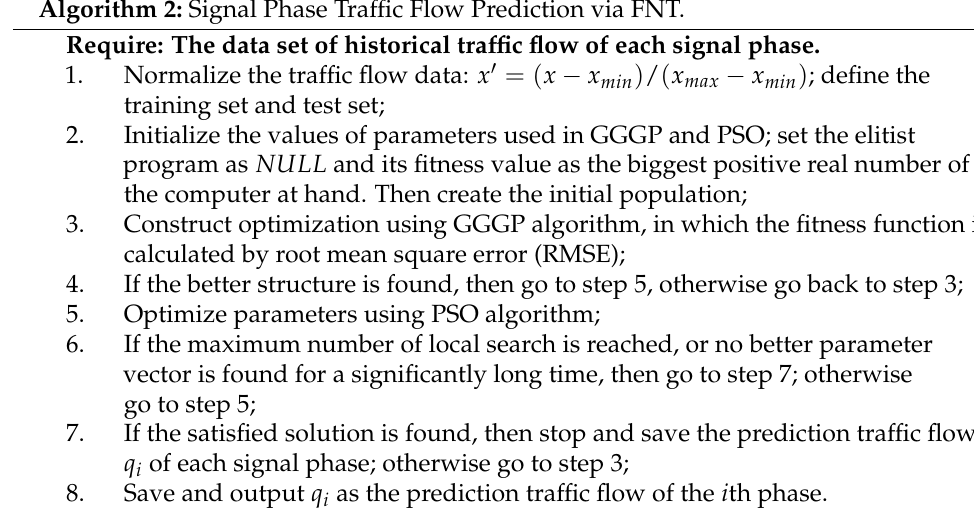
Algorithm 2: Signal Phase Traffic Flow Prediction via